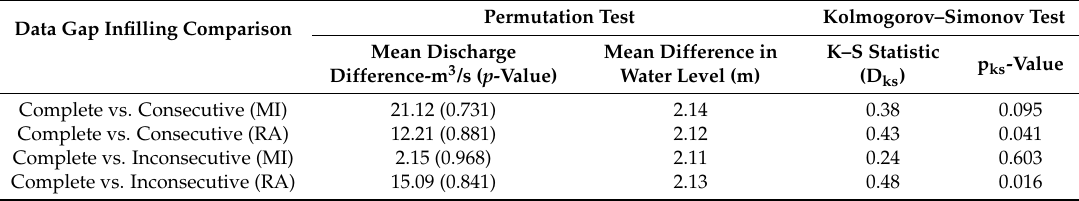
Table 12. Kolmogorov–Simonov and permutation test results, Taoussa gauging station, including the mean difference in water level between the two techniques.